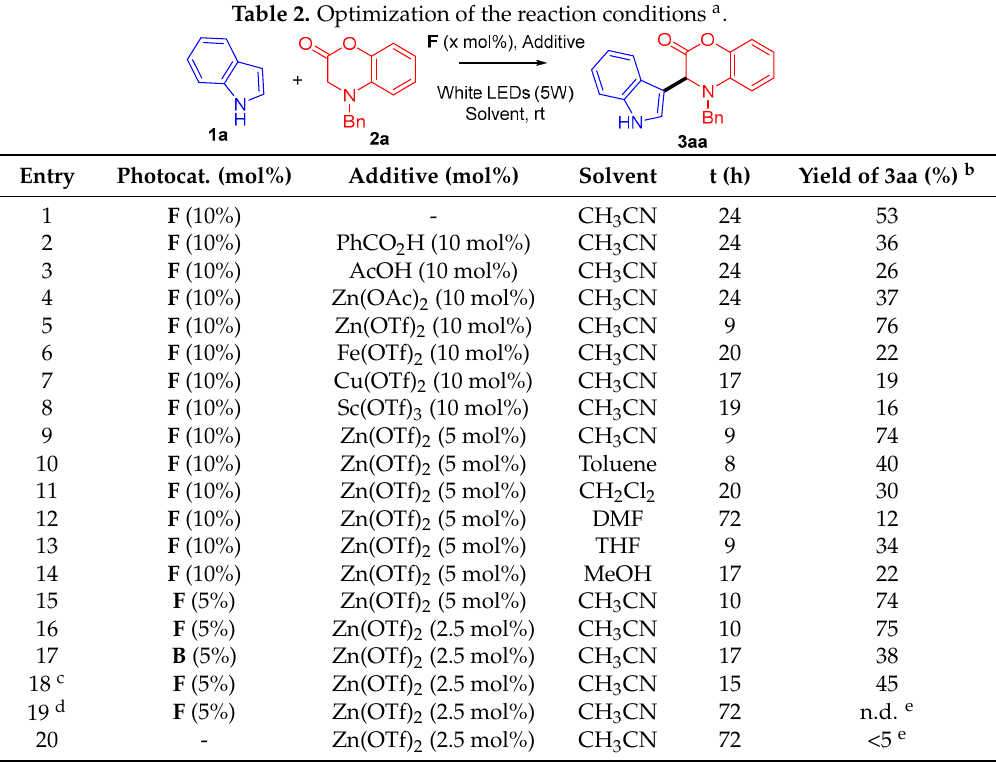
Table 2. Optimization of the reaction conditions a .